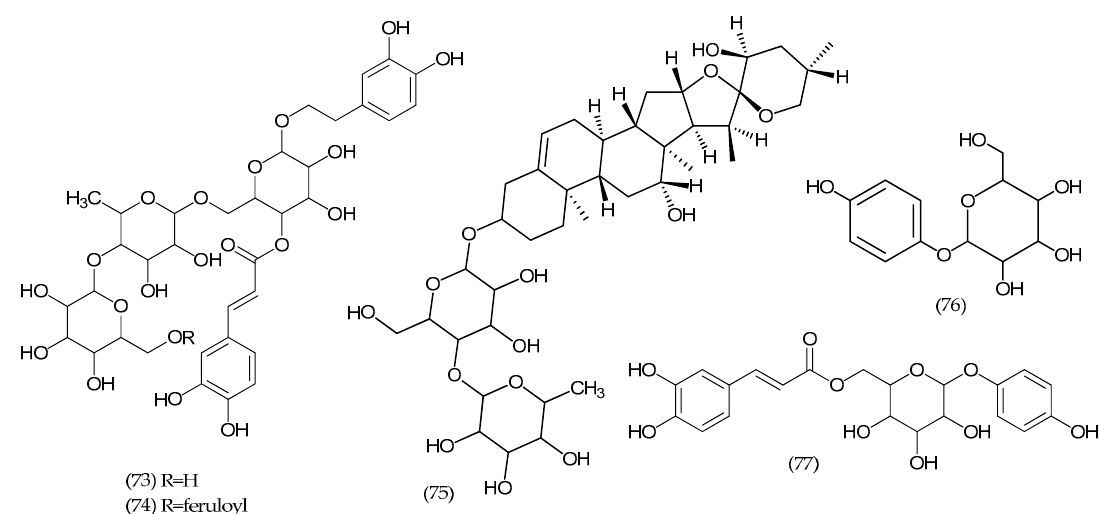
Figure 12. Phytoconstituents from Veronica turrilliana .